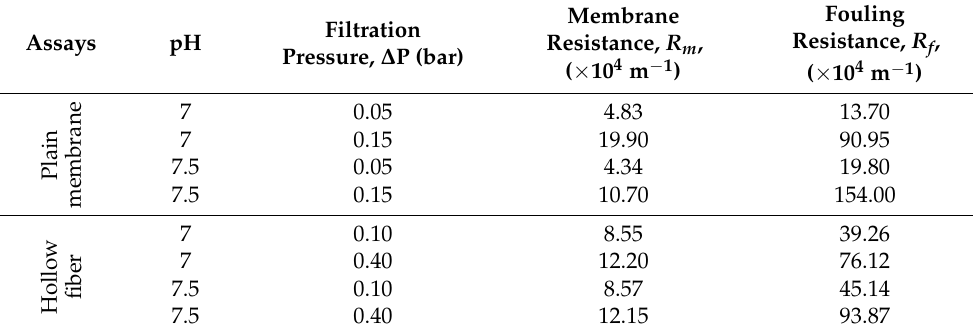
Table 2. Operational conditions after realized